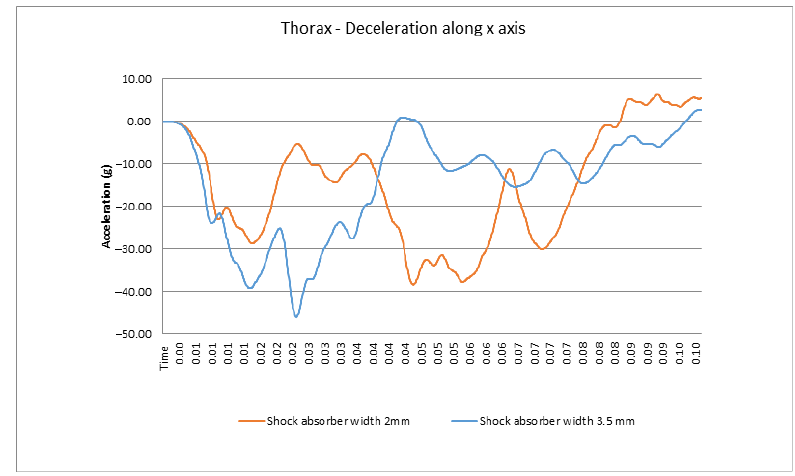
Figure 17. Acceleration registered by a virtual accelerometer in the pelvis, v = 13 m/s.